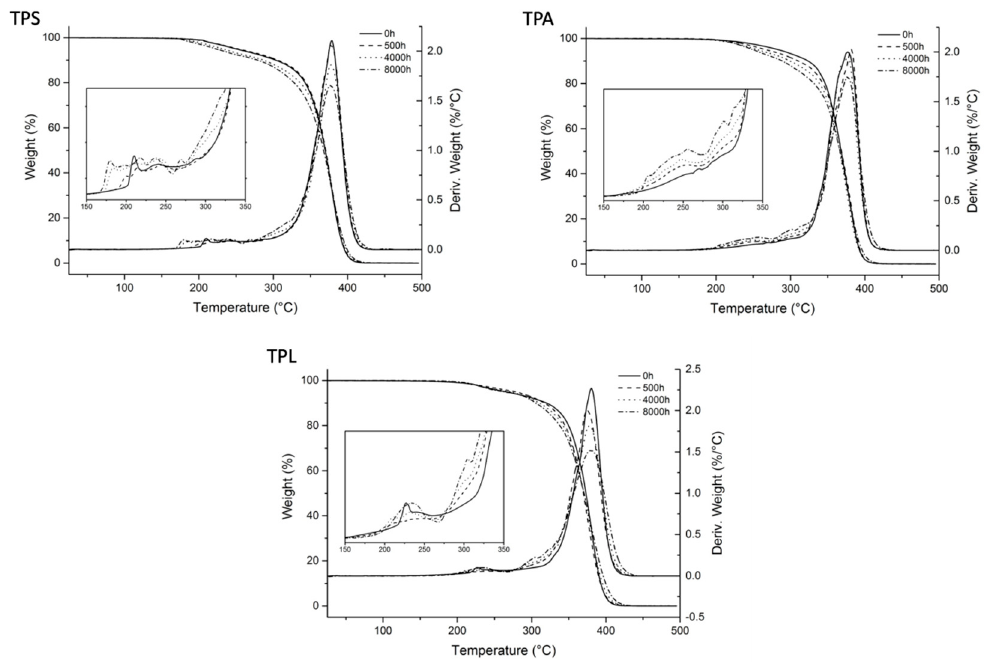
Figure 12. TG and DTG curves of the transparent samples after 0, 500, 2000, and 8000 h of irradiation.